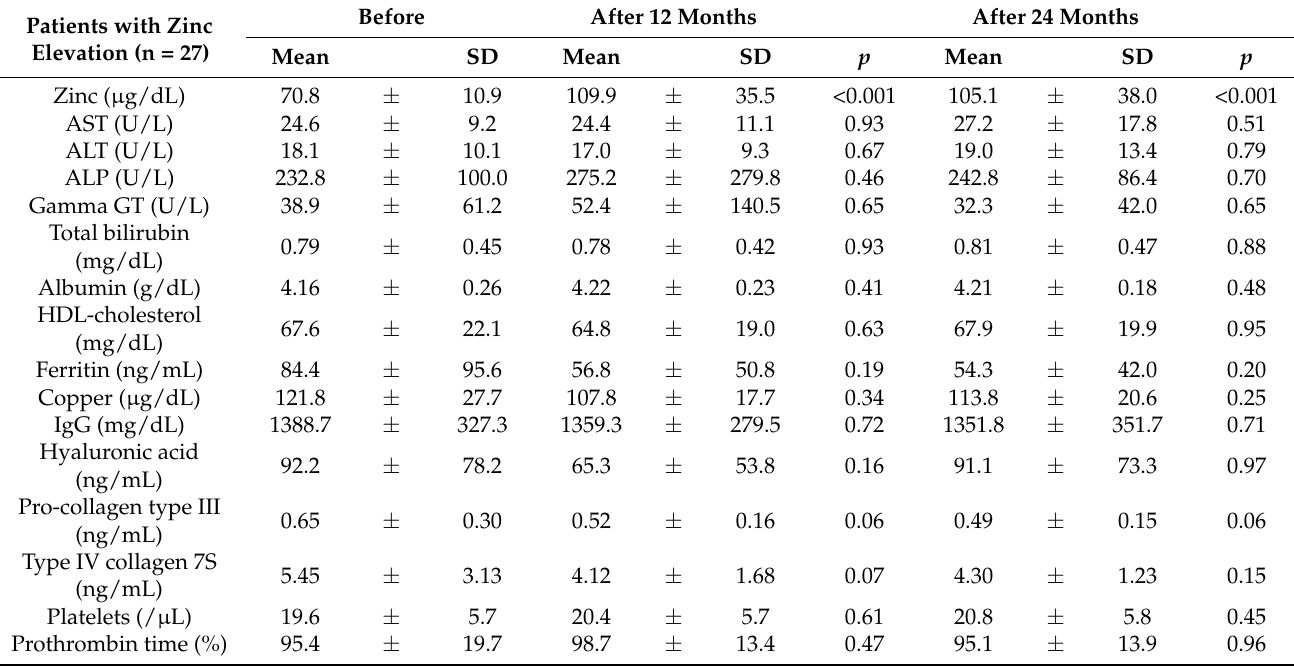
Table 2. Clinical parameters of the patients with zinc elevation before and after zinc